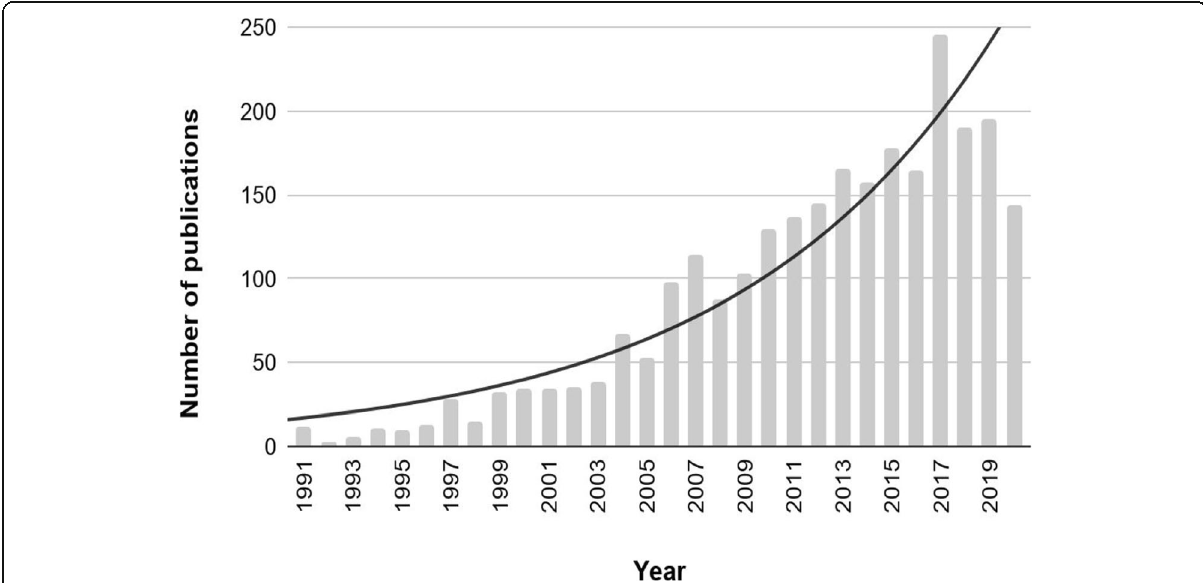
Fig. 2 Graphical representation of the number of publications per year on biological applications of second harmonic generation microscopy between 1990 and 2020. A more significant increase is noted from year 2000